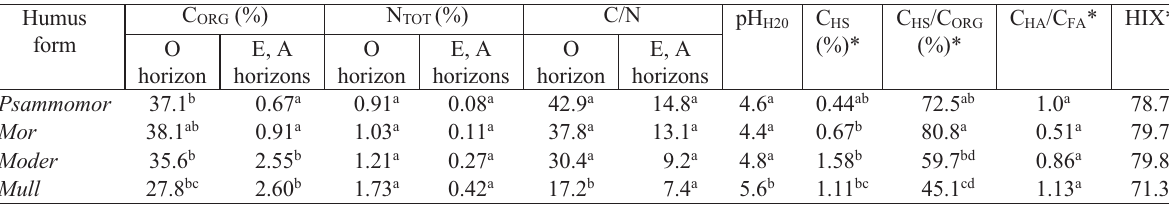
Table 6. Properties of soil organic matter within different humus